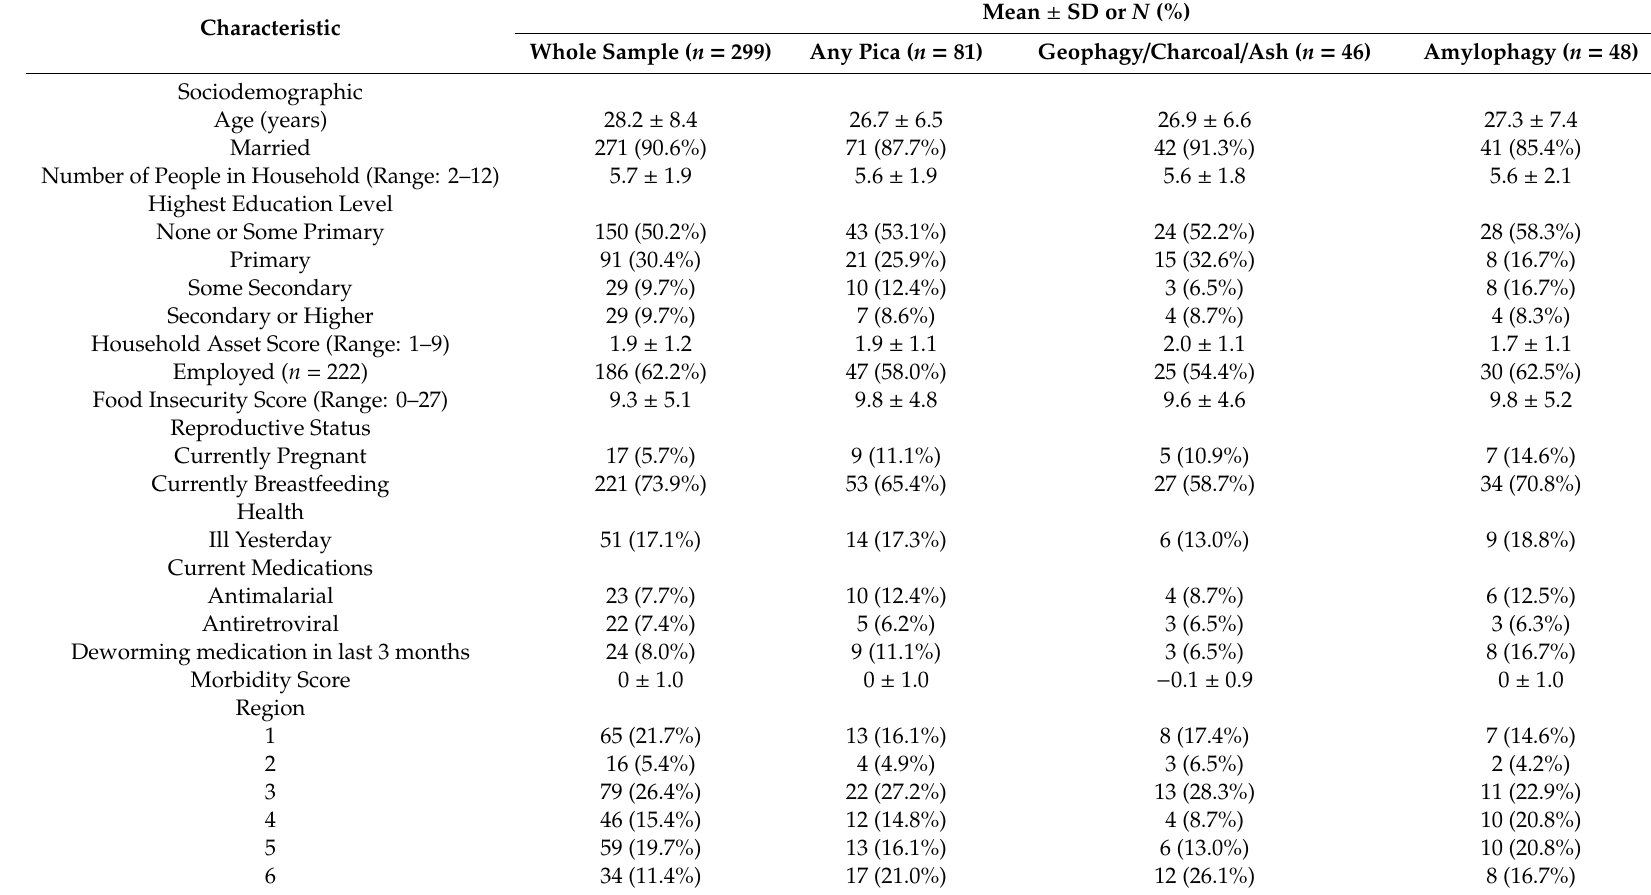
Table 1. Sample characteristics of mothers with children under 2 years, Mfangano Island,